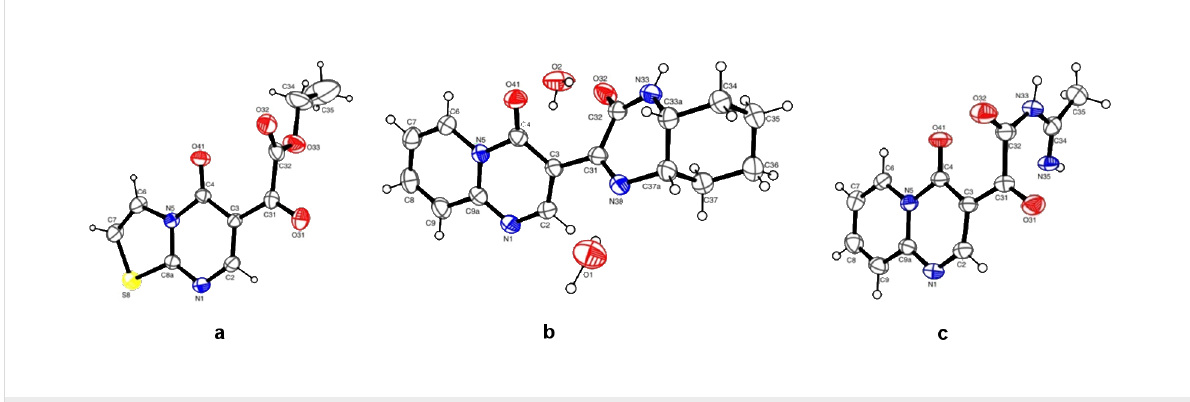
Figure 1: ORTEP plot of 6 , 9c , and 12g with the thermal ellipsoids drawn at the following probability levels: (a) 20%, (b) 50%, and (c) 40%.